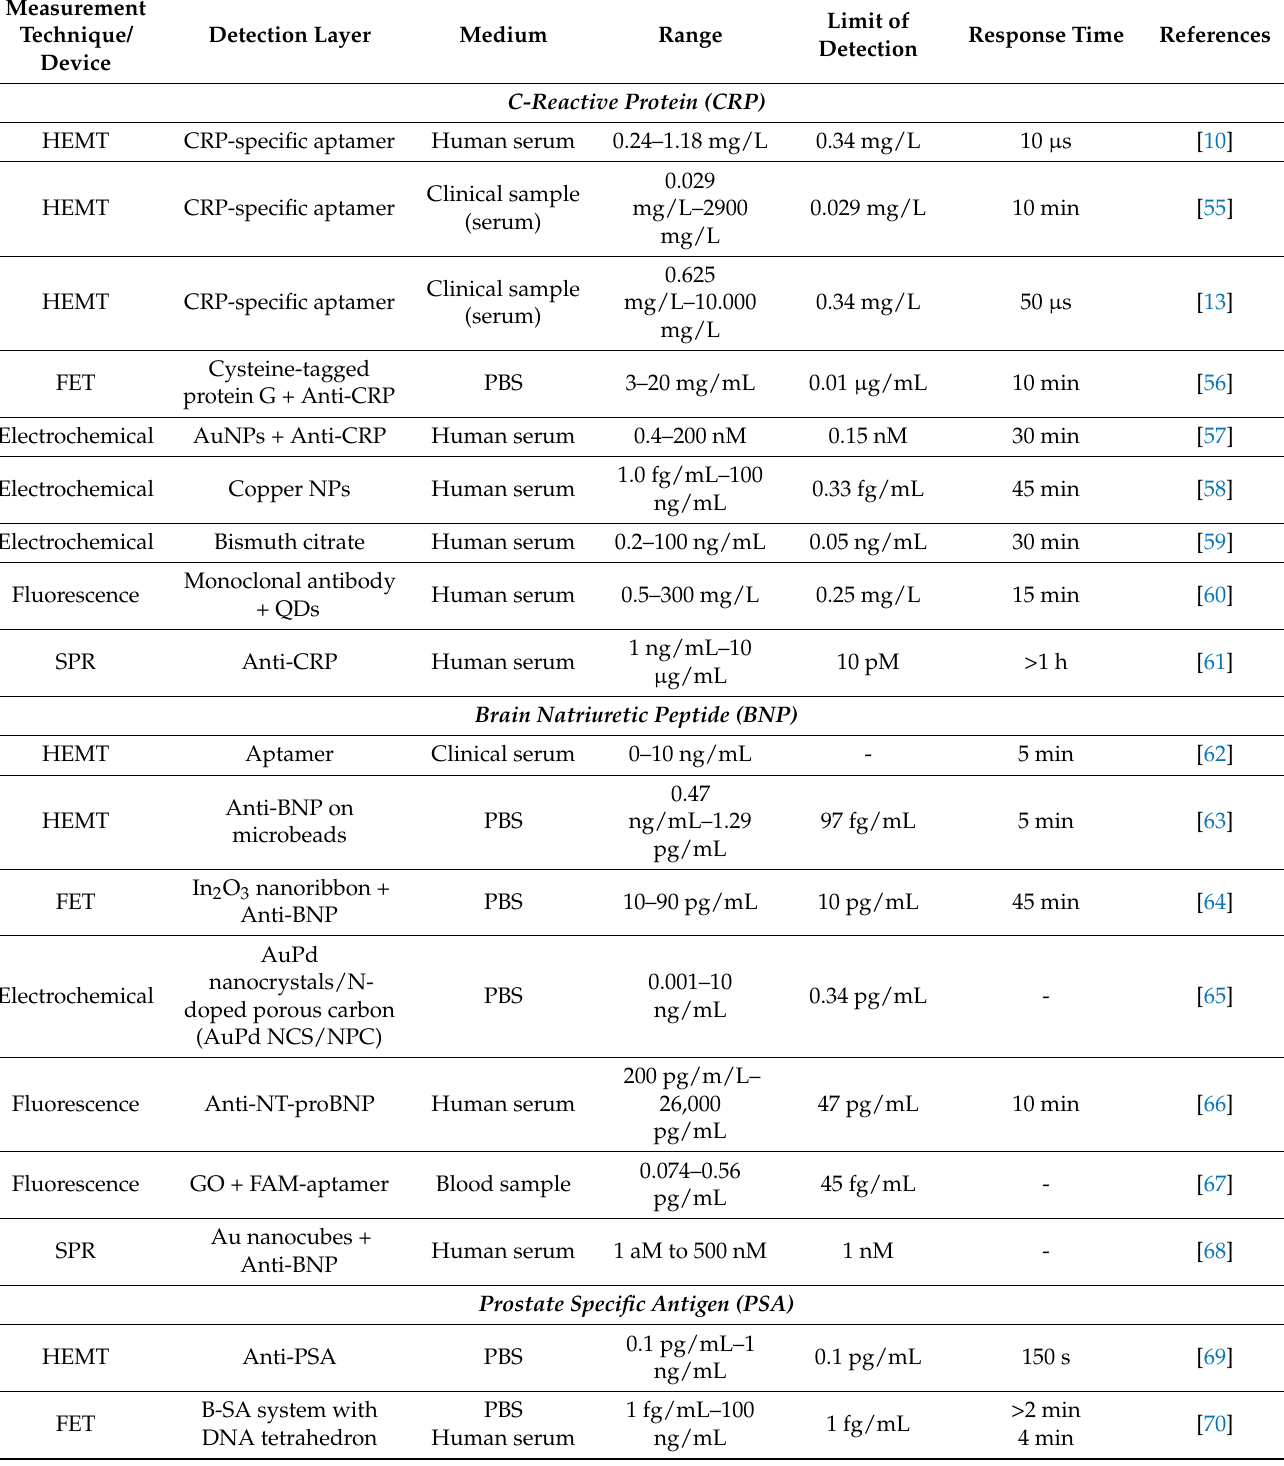
Table 1. The characteristics of several biosensors for detection of CRP, BNP, PSA, HER2/C-erB-2 and CA